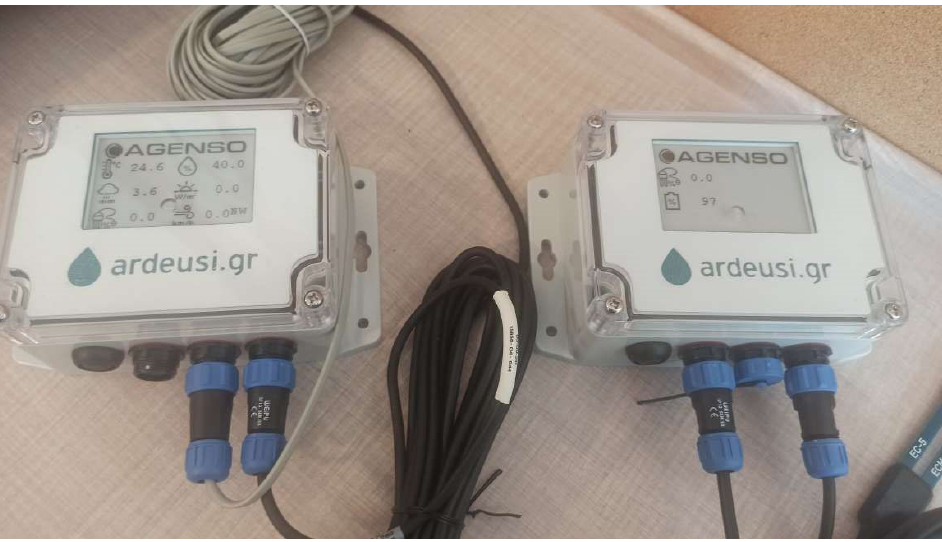
Figure 3. Photograph of sensor node 1 and sensor node 2.